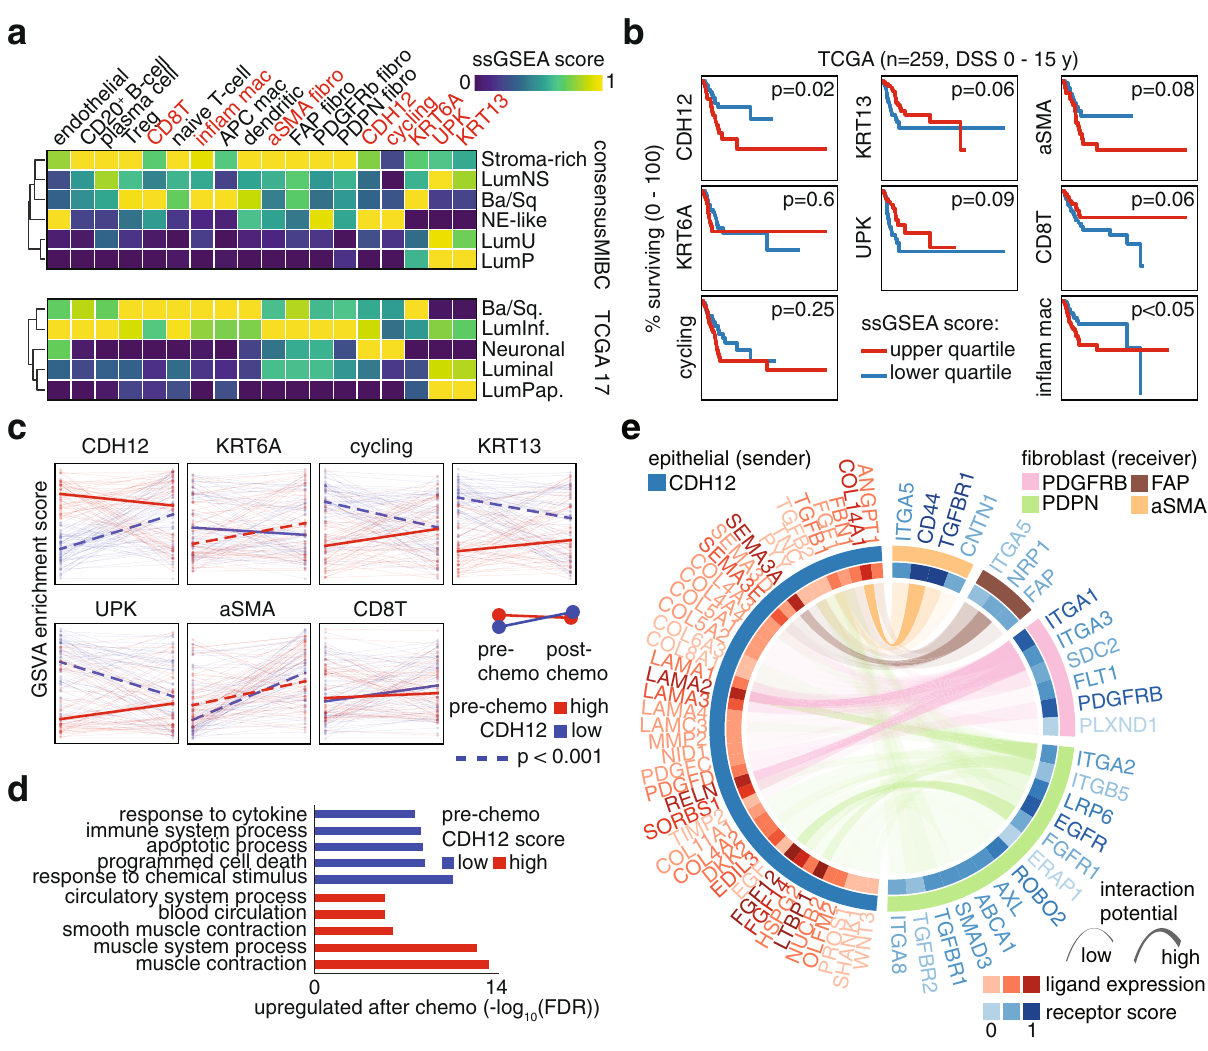
Fig. 3 High CDH12 scores predict chemoresistance and fi broblast activation. a Average snSeq-derived signature scores in molecular subtypes of TCGA MIBC cases ( N = 259). Signatures highlighted in orange are shown in b . b Disease speci fi c survival of high-grade MIBC in TCGA strati fi ed by snSeq population signatures (log-rank test between top and bottom quartiles, N = 259). c Tracking of 7 snSeq population signature scores in matched pre-chemo (left edge) and post-chemo samples (right edge) strati fi ed by their pre-chemo CDH12 signature score (dark line indicates median of all samples shown as light lines, blue lines — low pre-chemo CDH12 score, red lines — high pre-chemo CDH12 score) (dashed line indicates p < 0.001 for post-versus pre-chemo scores, Wilcoxon paired one-sided rank-sum test). d GO term enrichment (hypergeometric overlap test) for genes up-regulated post-chemo in tumors with low or high CDH12 score in the pre-chemo setting. e snSeq-derived receptor-ligand interactions signi fi cantly enriched between the CDH12 population and each fi broblast population (see Methods for